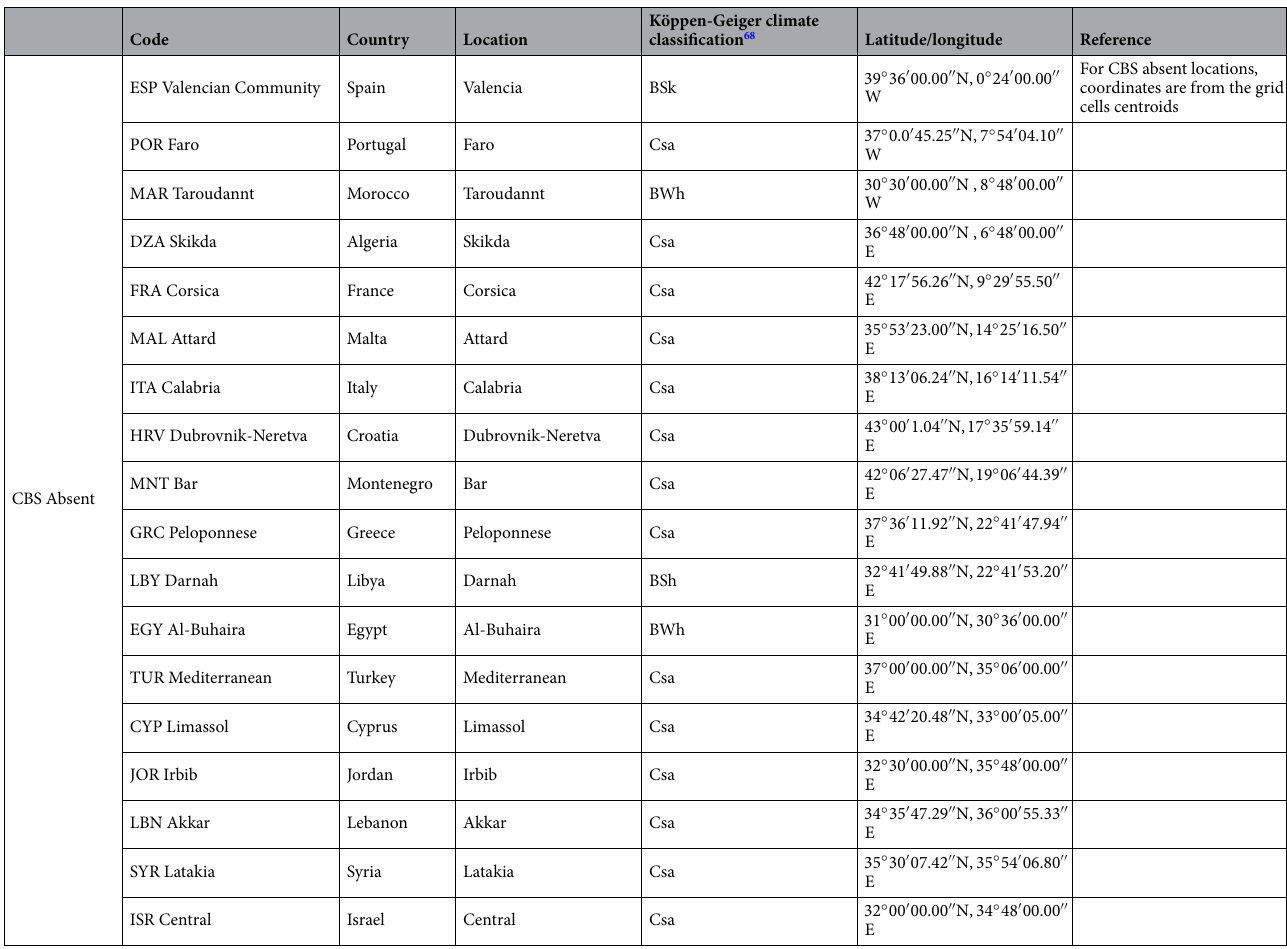
Table 2. Locations where citrus black spot (CBS) is either present or absent included in the climate suitability